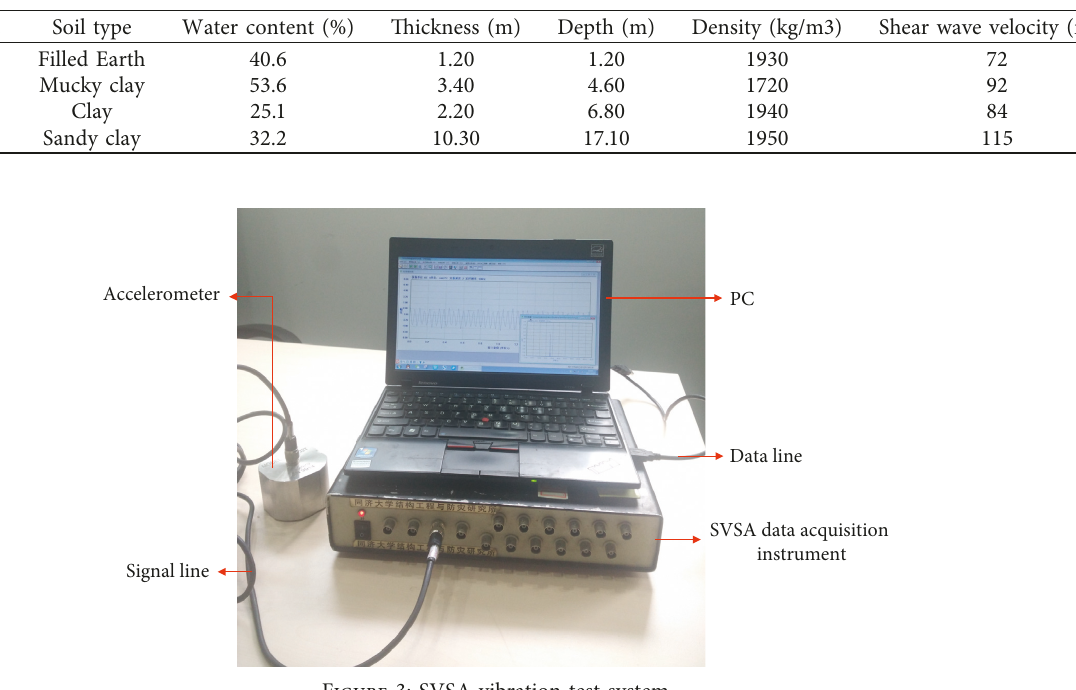
Table 1: Soil parameters of different soil layers.